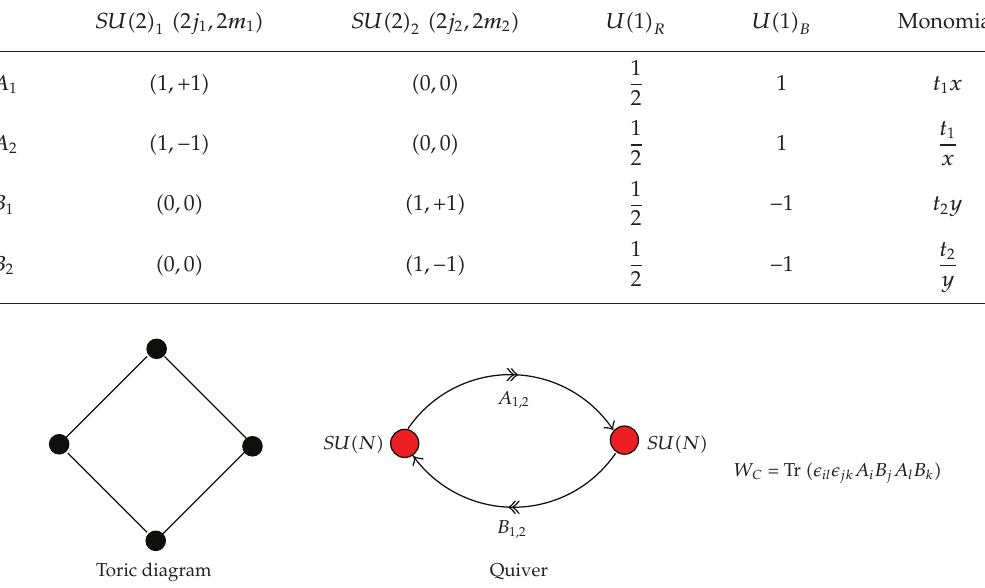
Figure 1: The quiver and toric diagrams, as well as the superpotential for the conifold C